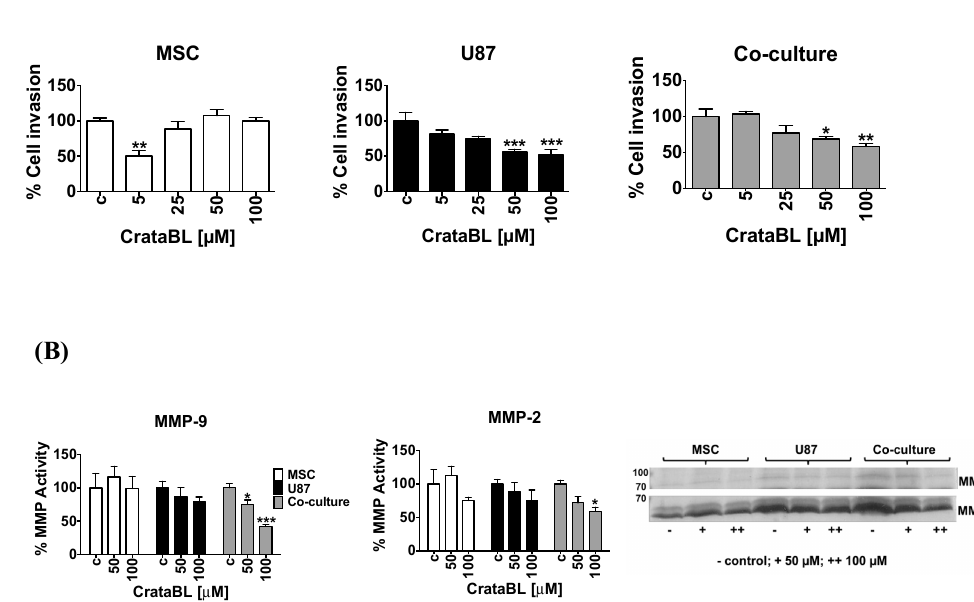
Figure 3. The effects of CrataBL on the invasion and metalloproteases activity secretion of MSCs, U87 cells, and cocultured cells. The invasion through the matrigel layer was evaluated as the percentage of invasion normalized to nontreated cells as control (c) in MSC, U87 glioblastoma cells, and cocultured cells ( A ). CrataBL influenced metalloprotease activity as observed by gelatin zymography gel assay and quantified for metalloproteases MMP-9 ± 84 / 92 kDa and MMP-2 ± 64 / 72 kDa ( B ). Densitometry analyses showed a diminished activity of MMP-2 and MMP-9 in the cocultures. ( − ) indicates control, ( + ) indicates 50 µ M of CrataBL and ( ++ ) 100 µ M of CrataBL in MSC, U87 and coculture. Significance was considered at * p < 0.05, ** p < 0.005, and *** p < 0.0005.